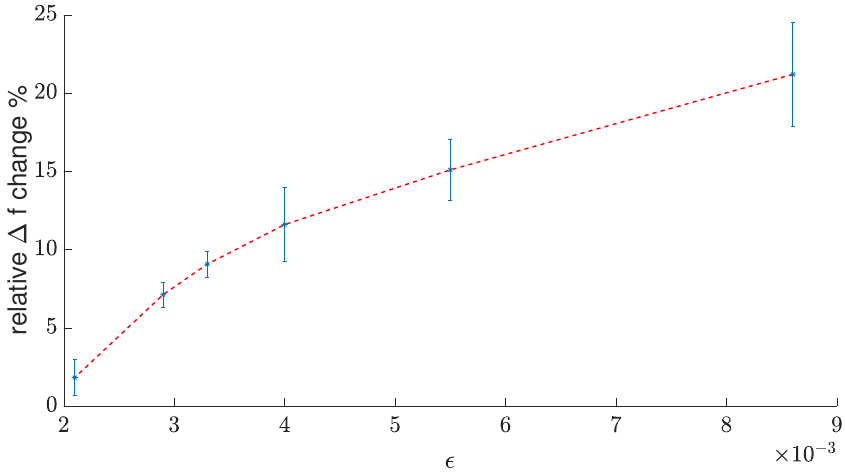
Figure 19. Relative frequency deviation vs.